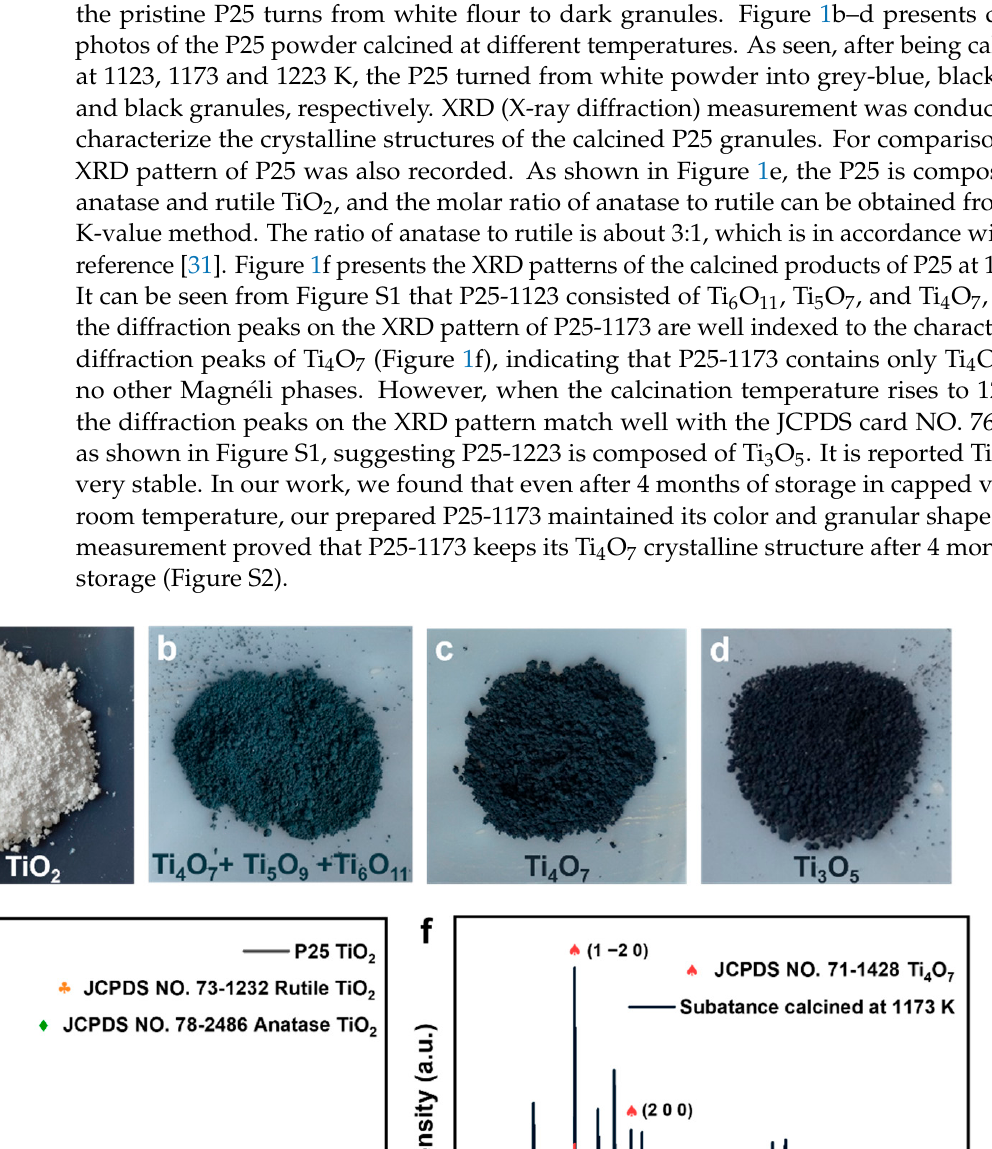
Figure 2. ( a ) TEM and ( b ) HRTEM images of P25 TiO 2 . ( c ) SEM, ( d ) HRTEM, and ( e ) TEM images of Ti 4 O 7 . 2.2. Synthesized Pt/Ti 4 O 7 Catalysts 2.2.1. Morphologies and Crystalline Structures Pt/Ti 4 O 7 with different Pt loading levels were synthesized using the modified polyol method by varying the mass ratio of P25-1173 to Pt. XRD measurements were obtained to investigate the crystalline structures of the Pt/Ti 4 O 7 samples with different Pt loadings. As shown in Figure 3a, even after 12 h of the reduction reaction at 433 K, the diffraction peaks of all the three Pt/Ti 4 O 7 samples were still well indexed to the characteristic diffraction peaks of Ti 4 O 7 , implying that P25-1173 maintained its crystalline structure even after 12 h